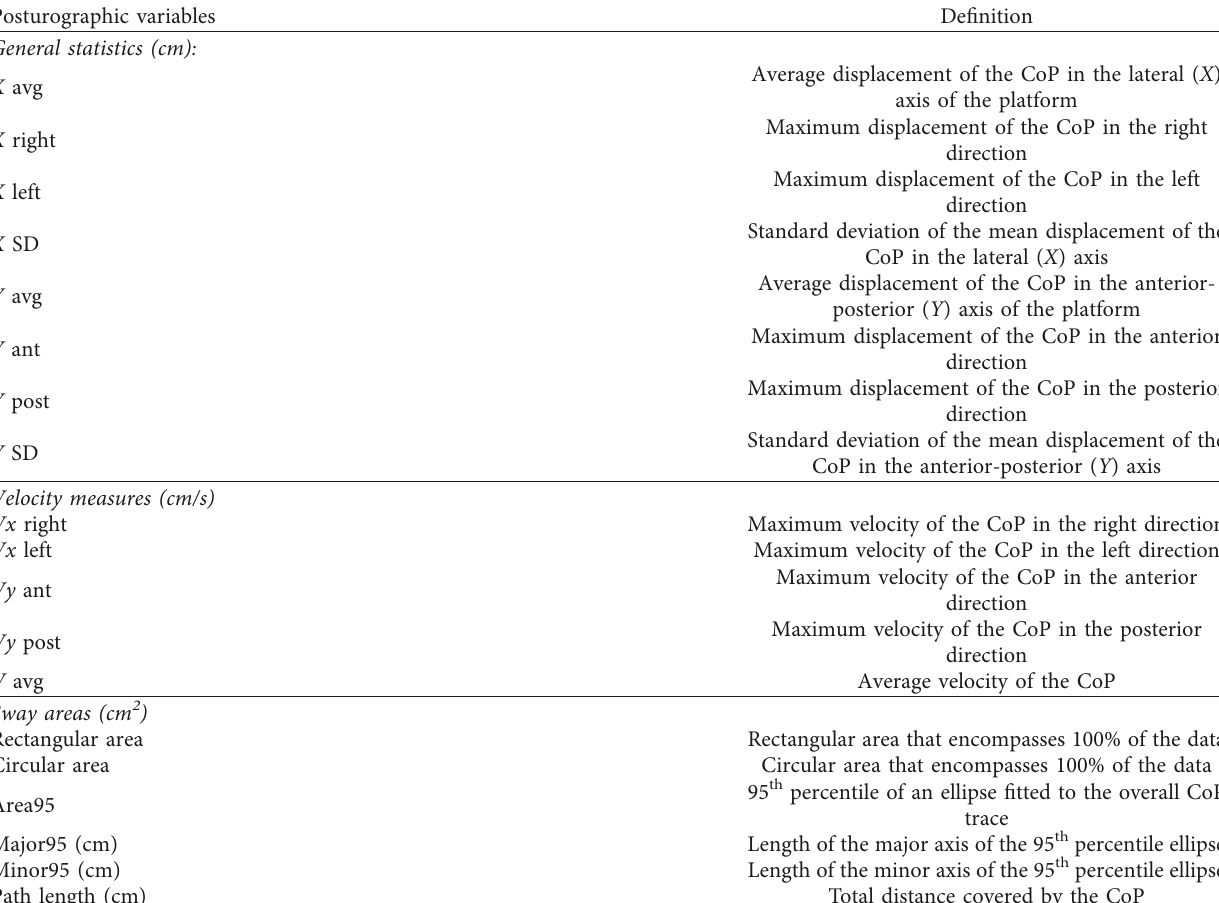
Table 1: Posturographic